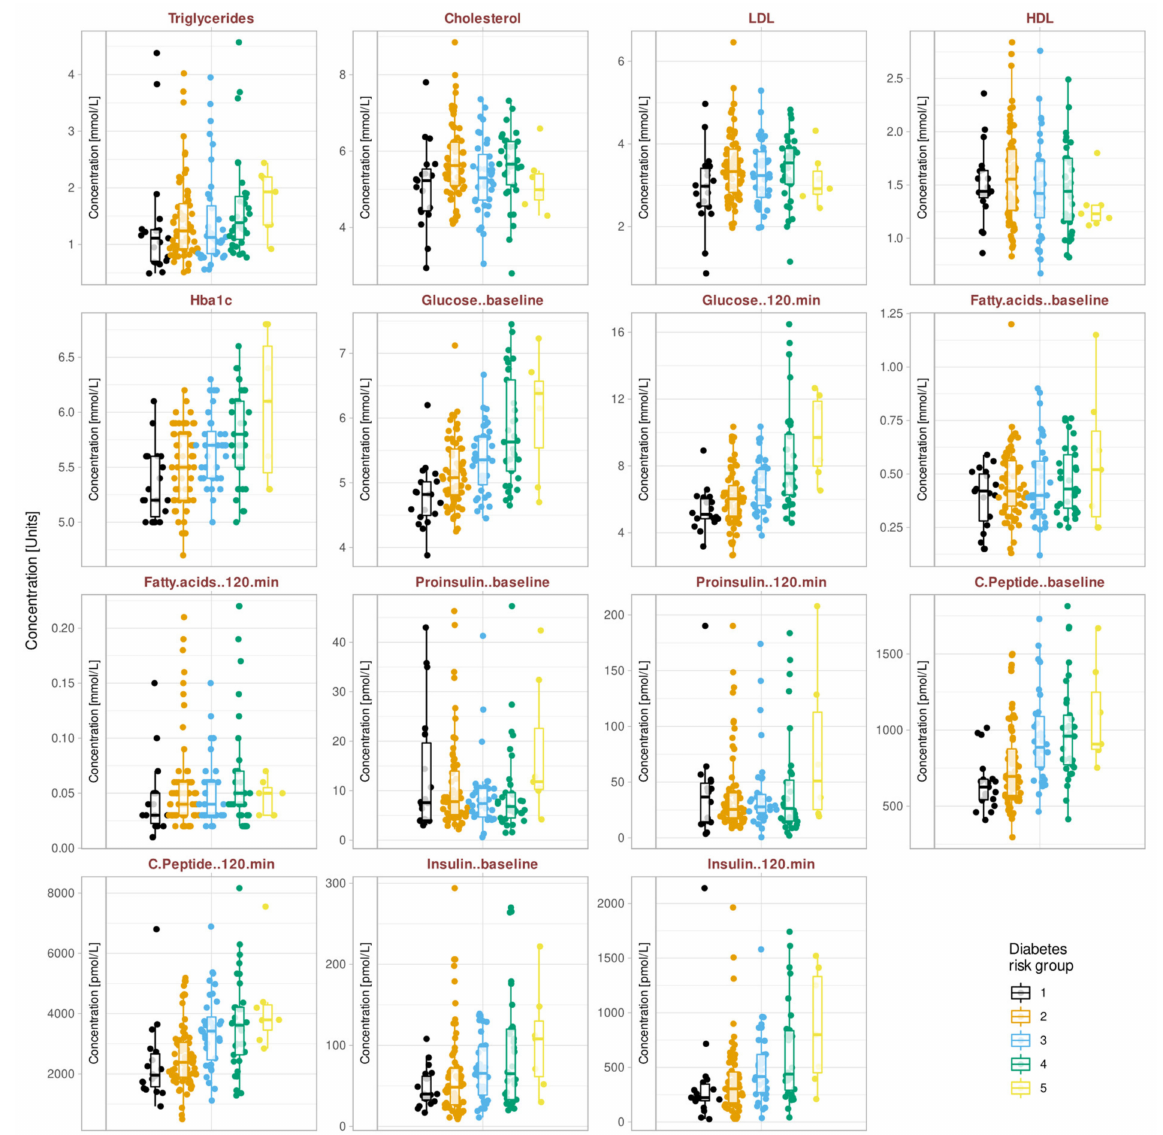
Figure 3. Raw metabolomics data. The data are plotted separately for the five diabetes risk groups according to the FINDRISK score (1 = “low risk”, 2 = “slightly increased risk”, 3 = “medium risk”, 4 = “high risk”, and 5 = “very high risk”). Individual data are shown as dots; six outliers removed from the further analysis are not shown to ensure discernibility of the projection of data points onto the ordinate. The original data are overlaid with boxplots, constructed using the minimum, quartiles, median (solid line within the box), and maximum. The whiskers add 1.5 times the interquartile range (IQR) to the seventy-fifth percentile or subtract 1.5 times the IQR from the twenty-fifth percentile. The figure has been created using the R software package (version 4.0.5 for Linux; https://CRAN.R-project.org/ [54]) and the R package “ggplot2” (https://cran.r-project.org/package=ggplot2 [112]). The colors were selected from the “colorblind_pal” palette provided with the R library “ggthemes” (https://cran.r-project.org/package=ggthemes